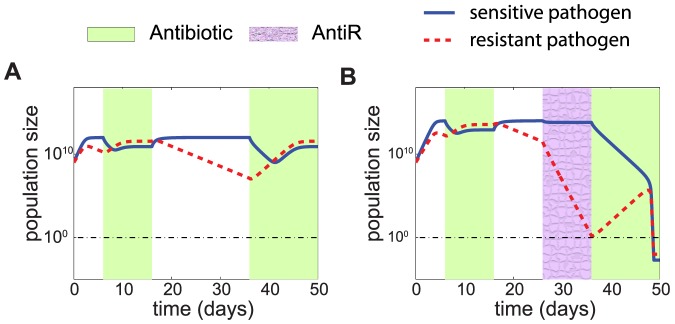
AntiR treatment boosts resistance attenuation and leads to total healing.Both antibiotic suspension (no treatment) and antiR treatment can reduce the abundance of resistant pathogens. However, this reduction is greater under antiR treatment. This figures illustrates the potential advantage of an antiR treatment in fighting a resistant infection. When no treatment is applied, the fraction of resistant population decreases slowly (A and B, time window between 16 and 36 hours) and it is followed by an ineffective antibiotic treatment. In (B), the resistance attenuation is faster due to treatment against resistance (antiR, purple-shaded area), and leads to an effective antibiotic treatment (t>36h). The black dashed horizontal line marks a single cell, i.e. the level below which the infection is healed. The initial abundance of both sensitive and resistant pathogens is 109 cells. Note that the period of antibiotic suspension preceding an antiR treatment is not necessary for an optimal therapy and is shown in this figure only for highlighting the different slopes.